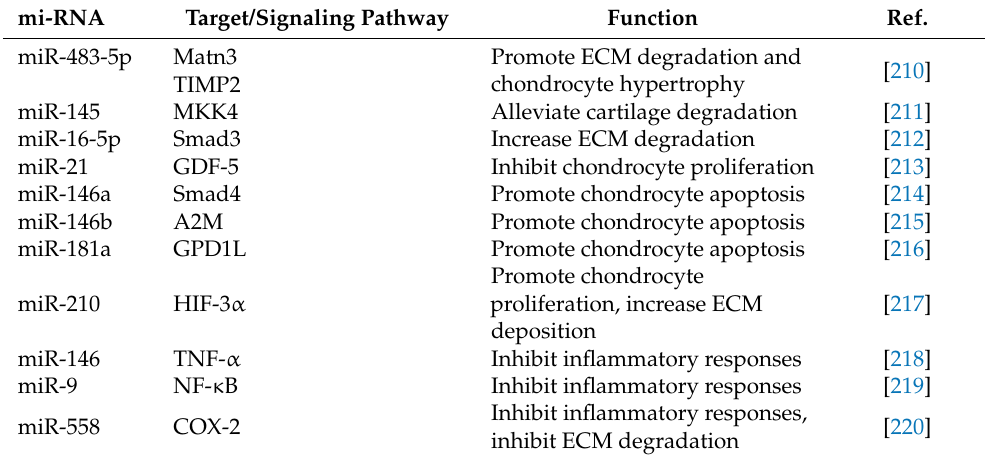
Table 4. Classifications and biological functions of mi-RNAs in osteoarthritis. mi-RNA Target/Signaling Pathway Function Ref. miR-483-5p Matn3 Promote ECM degradation and [210] chondrocyte hypertrophy TIMP2 miR-145 MKK4 Alleviate cartilage degradation [211] miR-16-5p Smad3 Increase ECM degradation miR-21 GDF-5 Inhibit chondrocyte proliferation Promote chondrocyte apoptosis Promote chondrocyte apoptosis Promote chondrocyte apoptosis Promote chondrocyte proliferation, increase ECM